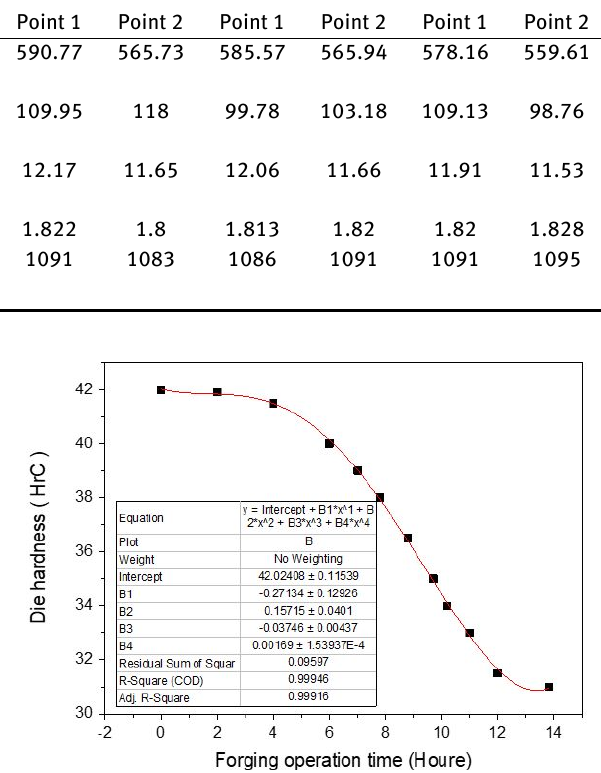
Figure 9: Upper and lower die hardness